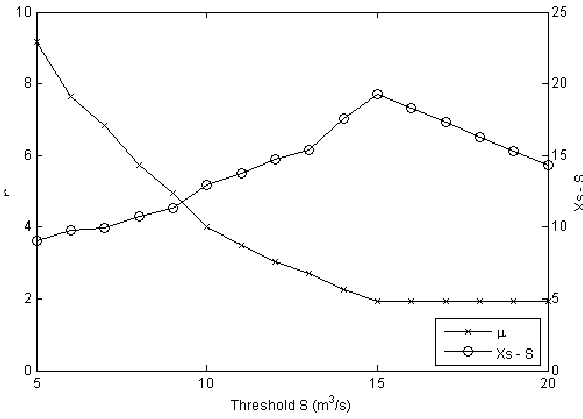
Figure 5 Threshold selection for the Alt Llobregat basin, using the Xs - S values to determine 2 Fig. 5. Threshold selection for the Alt Llobregat basin, using the xs – a stable range of S, and selecting a threshold with µ > 2 peaks per year. 3 s values to determine a stable range of s , and selecting a threshold with µ >2 peaks per